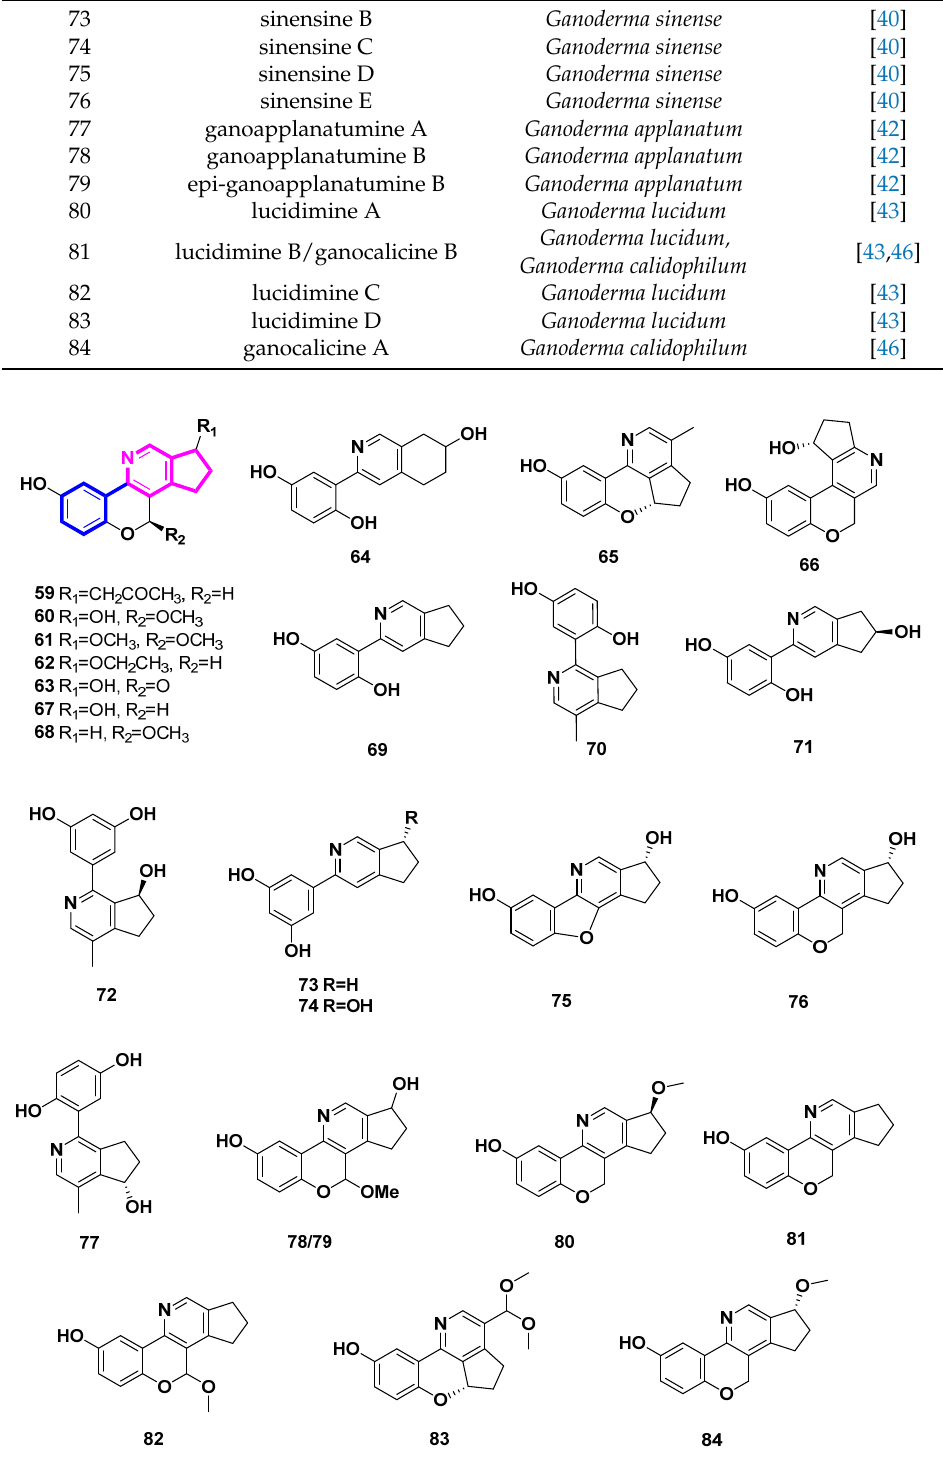
Figure 7. Structures of phenyl-substituted cyclopenta[c]pyridine derivatives (Type VI).